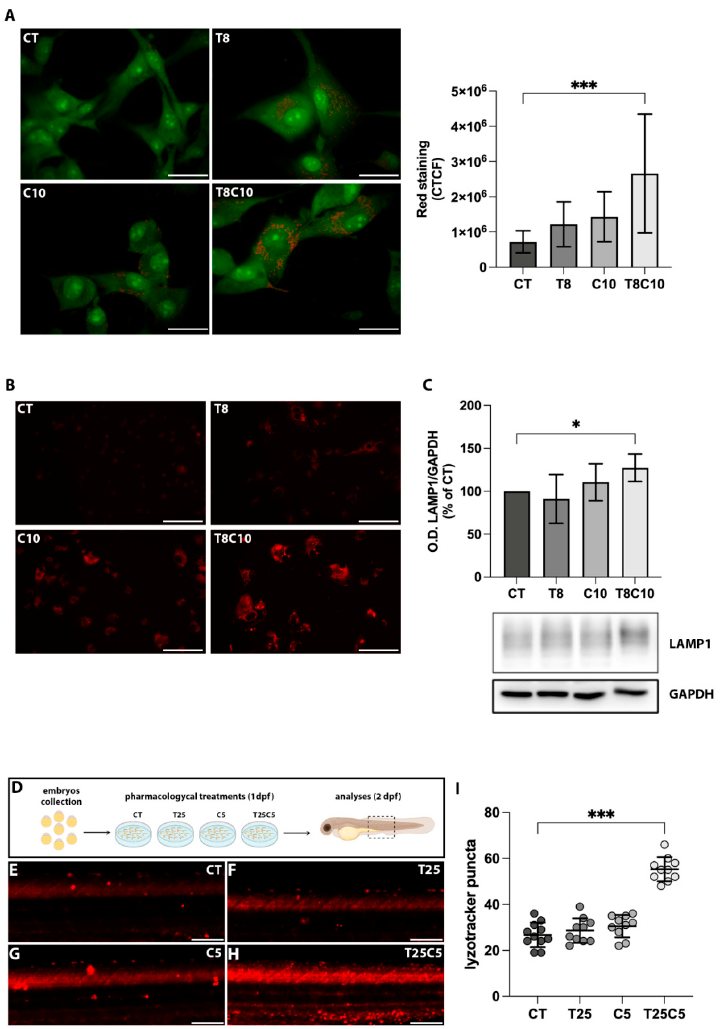
Figure 3. Combined HDAC6 and Hh inhibition altered acidic compartments. ( A ) U87-MG cells treated with vehicle (CT), 8 µ M of TubA (T8), 10 µ M of cyclo (C10), and 8 µ M of TubA +10 µ M cyclo (T8C10) for 48 h and stained with acridine orange. The AO accumulation into acidic com- partments is represented by red dots. Green fluorescence arose from AO binding to DNA and RNA ( B ). Quantitative analysis of red fluorescence was calculated as corrected total cell fluorescence (CTCF) ± standard deviation. ( C ) LysoTracker Red staining in U87-MG cells treated with or without T8, C10, or T8C10. ( D ) Western blot analysis of LAMP1 protein expression normalized against GAPDH. Data are expressed as the percentage of the CT. ( E ) Schematic description of the pharmaco- logical treatments in zebrafish. ( F – I ) Representative images of the trunk region of zebrafish embryos treated with 25 µ M of TubA (T25) or 5 µ M of cyclo (C5), alone or in combination, and stained with LysoTracker Red. ( I ) Quantification of the LysoTracker Red intensity in the trunk region of treated embryos. Scale bar indicates 40 µ m ( A ) and 100 µ m ( B , E – H ). Data are presented as mean ± standard deviation. CT—vehicle; TubA/T—tubastatin A; cyclo/C—cyclopamine. One-way ANOVA with Tukey post hoc correction. *** p < 0.001; * p < 0.05; nonsignificant data are not